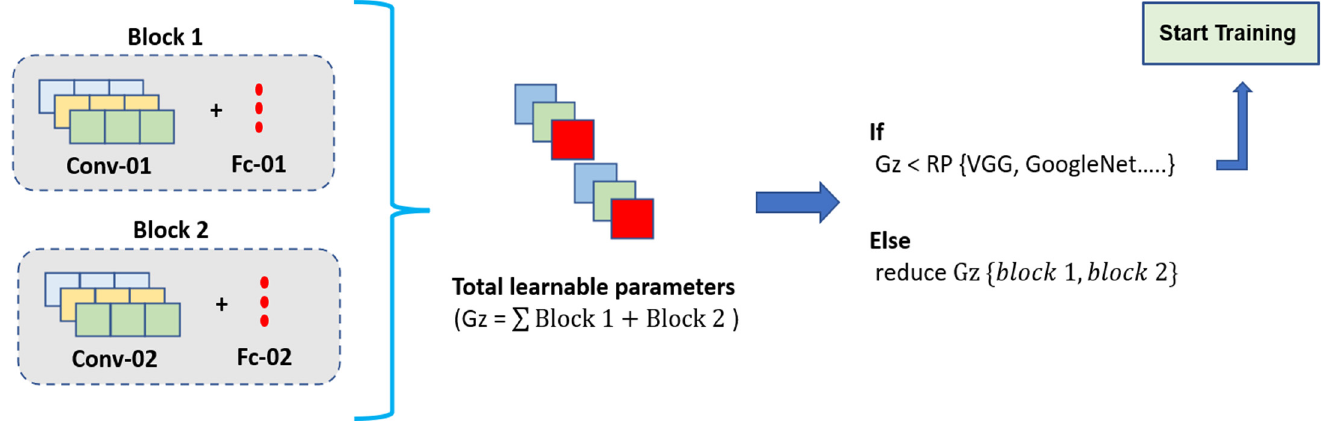
Figure 10. Proposed Framework For CNN Development.